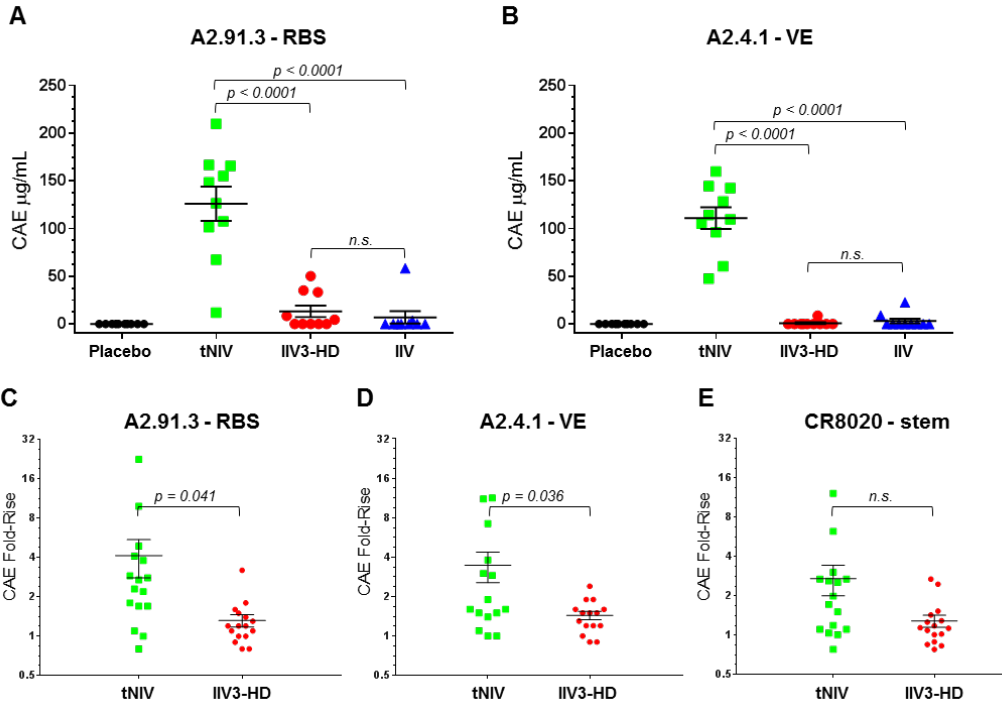
Figure 7. Competing antibodies in the sera of ferrets and older adults. ( A , B ) Age- and body weight-matched ferrets were immunized twice at a 3 week interval with 10 animals per group (placebo [PBS]; tNIV [15 mg / strain + 50 mg Matrix-M]; Fluzone HD [IIV3-HD, 60 mg / strain]; or Fluzone [IIV, 15 mg / strain]). Serum collected 3 weeks after the second dose (day 42) was tested for the presence of competing antibodies to the RBS A2.91.3 ( A ) or VE subdomain A2.4.1 ( B ). ( C , D , E ) Sixteen individuals each were chosen randomly from clinical trial groups (tNIV [60 mg / strain + Matrix-M]; or Fluzone HD [IIV3-HD, 60 mg / strain]). Serum samples were evaluated for the presence of antibodies that compete for binding with monoclonal antibodies to the RBS A2.91.3 ( C ), VE subdomain A2.4.1 ( D ), or stem CR8020 ( E ). Competitive antibody equivalents (CAEs) were measured by Octet QK384 with immobilized A / Hong Kong / 4801 / 2014 HA and fold-rise was calculated as the ratio from pre-immunization (day 0) to post-immunization (day 21) for each sample in the vaccination groups. Individual data points were superimposed by the arithmetic mean and SEM for each group. For samples below the limit of detection (LOD), values were set at half the LOD (0.5 µ g / mL). P-values were calculated using the Student’s t-test with p < 0.05 reported and p > 0.05 indicated as not significant (n.s.).